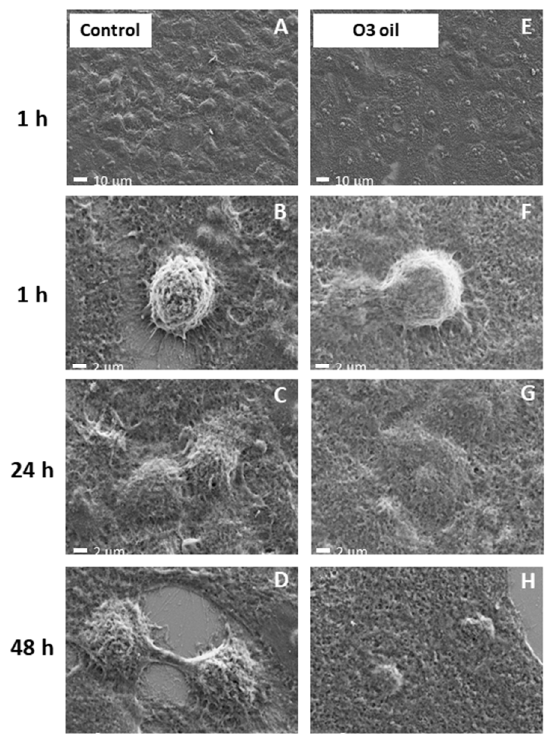
Figure 7. SEM images of the cells before ( A – D ) and after the ozonide oil (>700 ozonides) treatment ( E – H ) at a magnification of ×2000 ( A , E ) and ×10,000.